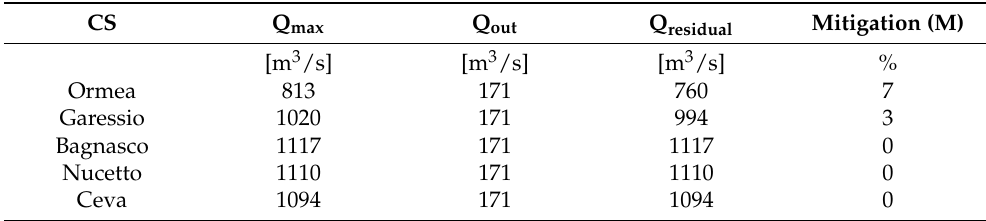
Table 9. The mitigation effect of the single Negrone River dam if it had a height of 30 m; the outgoing flow rate, calculated to optimize the efficiency of the retention dam using Equation (4), is equal to 171 m 3 /s.